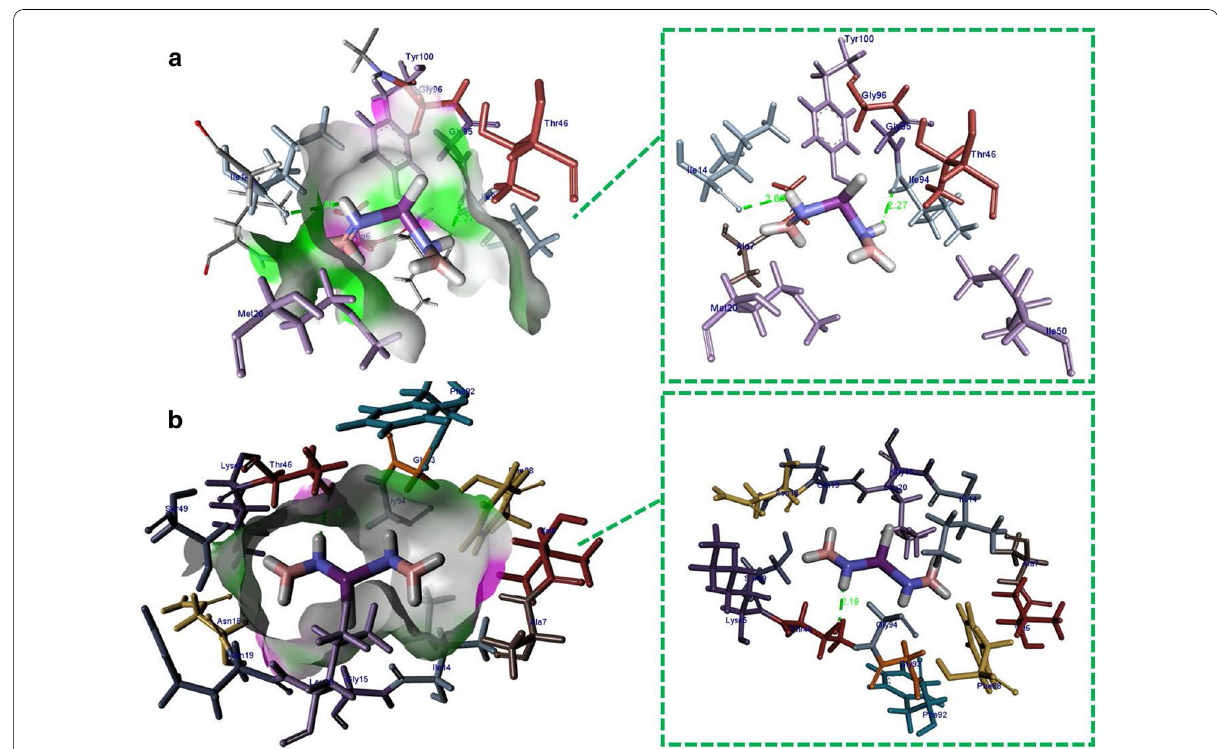
Fig. 10 Binding interaction pattern of Bi‑doped BN nanosheets with active site residues of dihydrofolate reductase from a E. coli and b S.